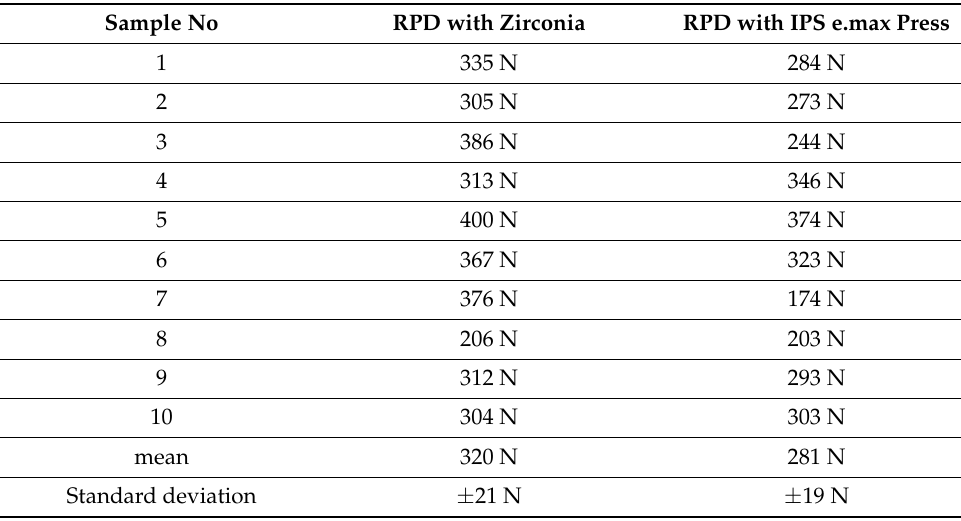
Table 2. The recorded values, mean and standard deviation of fracture strength of RPD (Co-Cr alloy) used with all-ceramic crowns (IPS e.max Press and zirconia